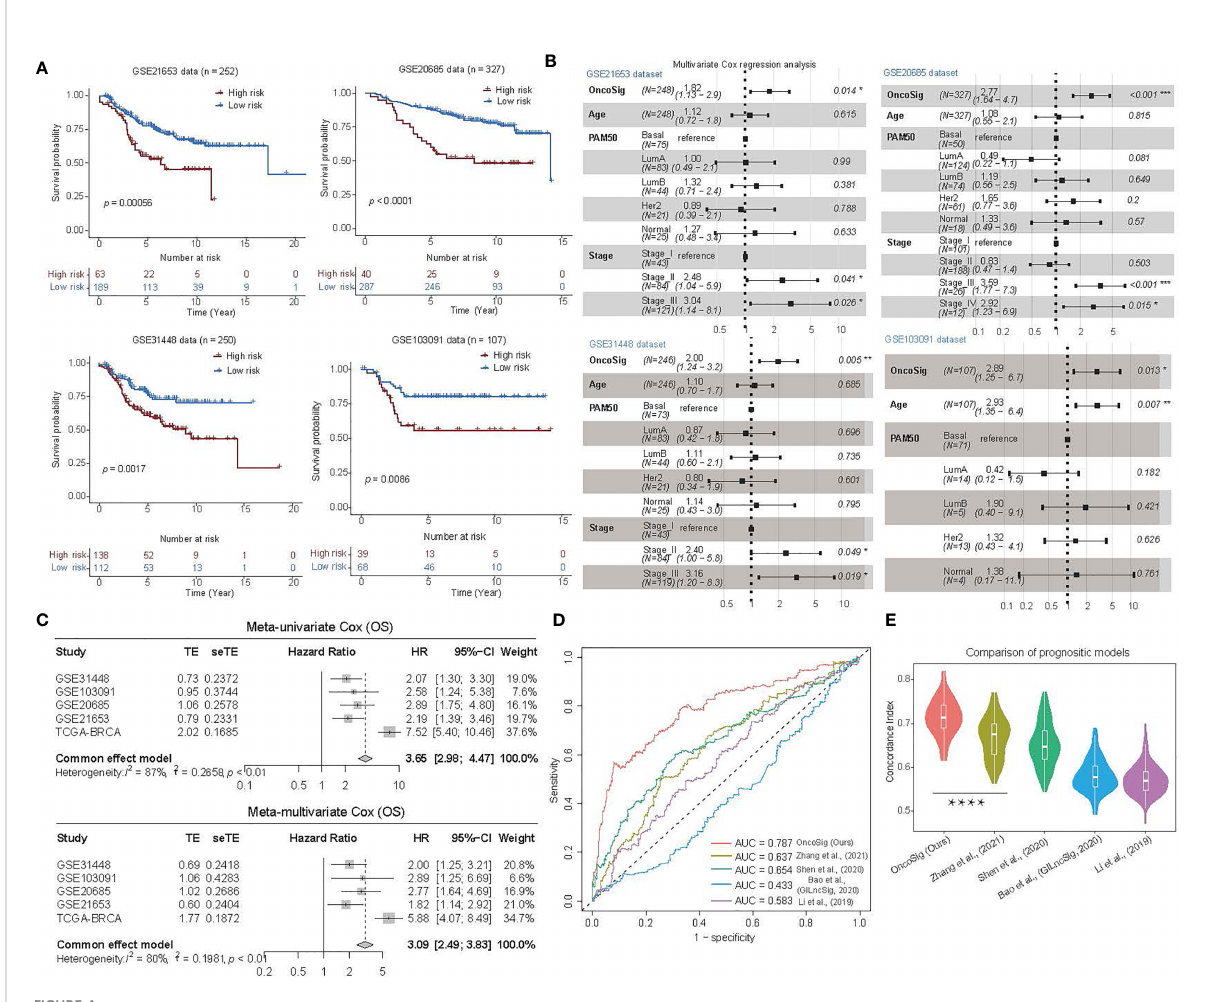
FIGURE 4 Prognostic performance of the OncoSig on four independent BC testing cohorts. (A) KM survival analysis for the OS curves of BC patients in GSE21653, GSE20685, GSE31448, and GSE103091, respectively. (B) Multivariate analysis of the OncoSig, age, PAM50, and stage with OS using the four testing cohorts, respectively. (C) Meta-analysis performed on the prognostic value of the OncoSig for patients in the fi ve cohorts, using a fi xed effects model to calculate pooled HR values (top: meta-univariate; bottom: meta-multivariate). (D) The ROC analysis of 5-year OS of the OncoSig versus other published prognostic signatures for BC. (E) Comparison of the performance of fi ve BC signatures using the concordance index (C-index), randomly permuted 100 times, with 200 patients randomly selected from TCGA-BRCA each time, and the C-index calculated separately for each signature. The Wilcoxon rank-sum test was used for the statistical analysis. **** p ≤